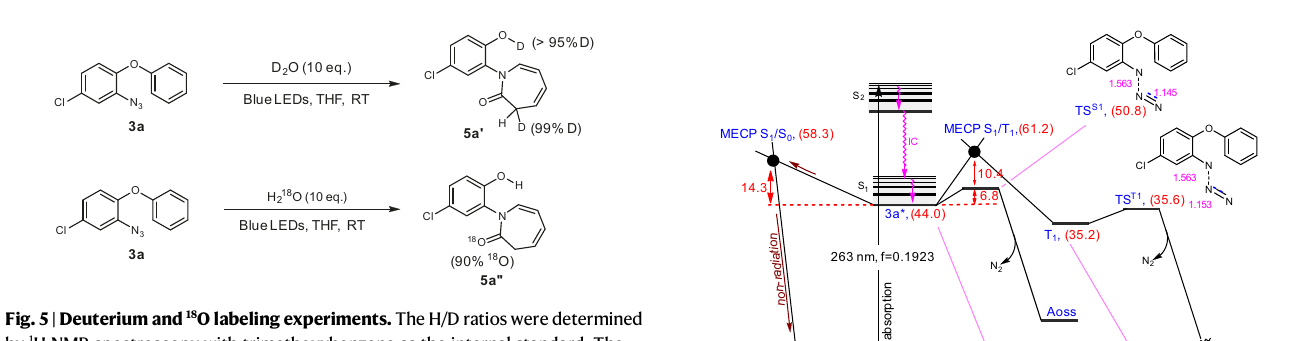
Fig. 4 | Important transformations based on the obtained products. All reactions are performed on a 0.2mmol scale. Isolated yields are given.